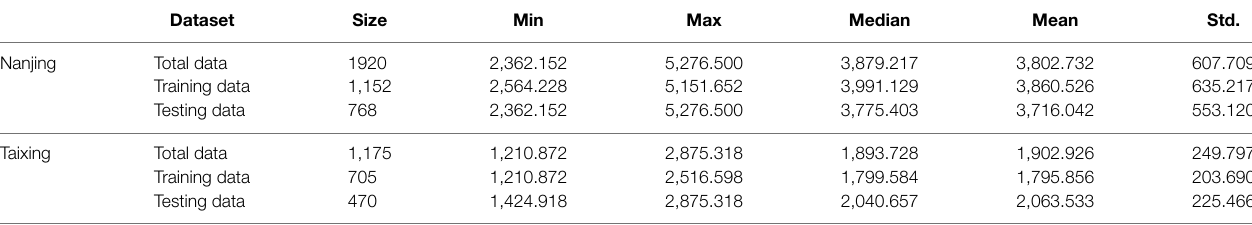
TABLE 1 | Characteristics of experimental data in Nanjing and Taixing. Dataset Min